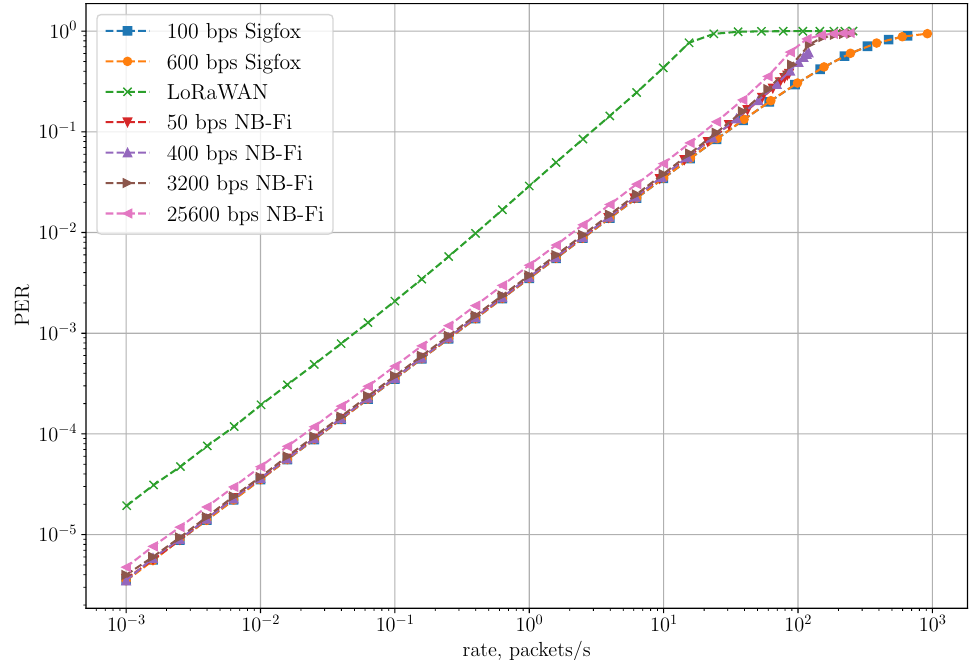
Figure 15. PER for the reliable transmission of short packets